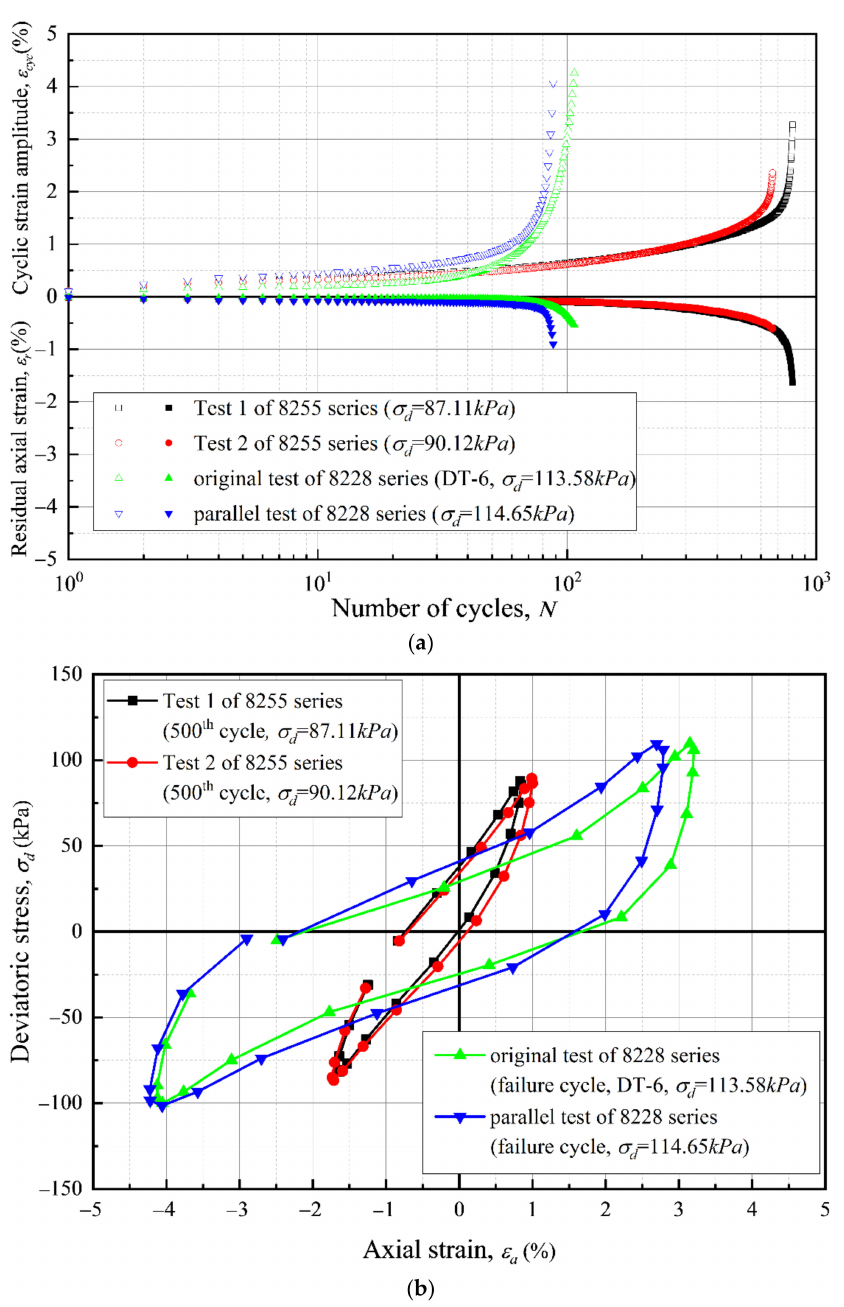
Figure 7. Dynamic characteristics of artificial marine clays in two series (test 1 and 2 of 8255 and original and parallel tests of 8228) under cyclic loading: ( a ) Relationship between number of cycles versus cyclic axial strain amplitude and residual axial strain (deviatoric stress is zero at each cycle); ( b ) Hysteresis curves of specific